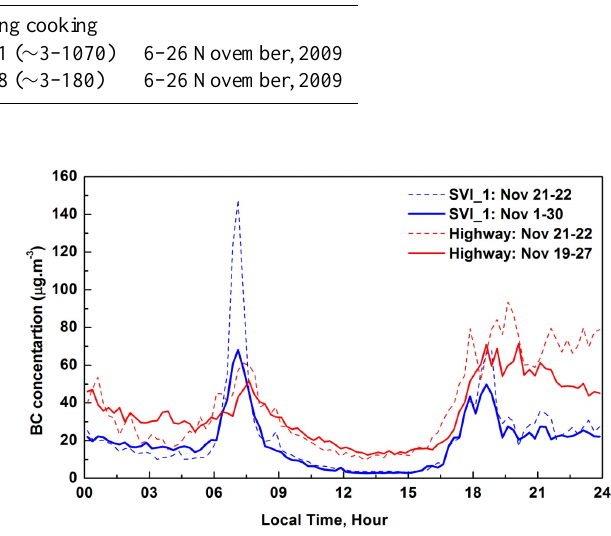
Fig. 4. 15-min median variation of BC concentration during al- tered cooking pattern during 1–9 September 2010 period for in- door (black solid line) and outdoor (red solid line) at Surya village (SVI 1). For comparison the 15-min median variation of BC con- centration during normal cooking pattern for indoor (dotted black line) and outdoor (dotted red line) are also shown.